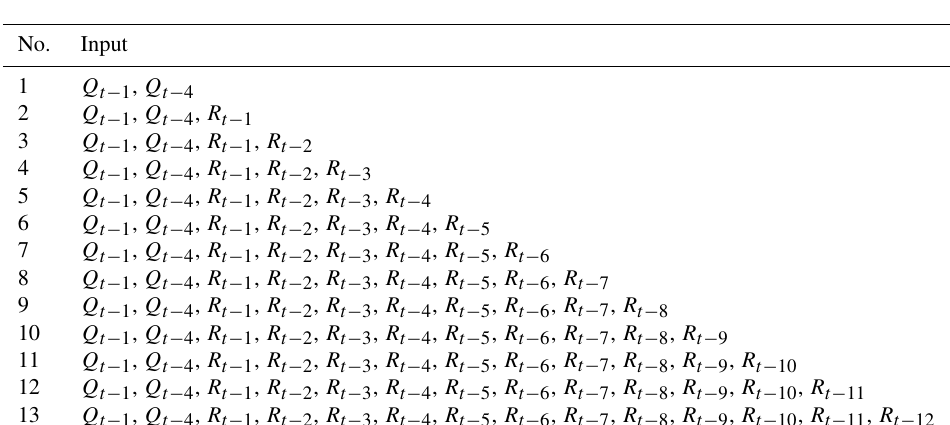
Figure 6. (a) The PACF plot of Xiaowan daily inflow, and (b) the CCF of Xiaowan rainfall and inflow. Table 1. The candidate inputs via the PACF and